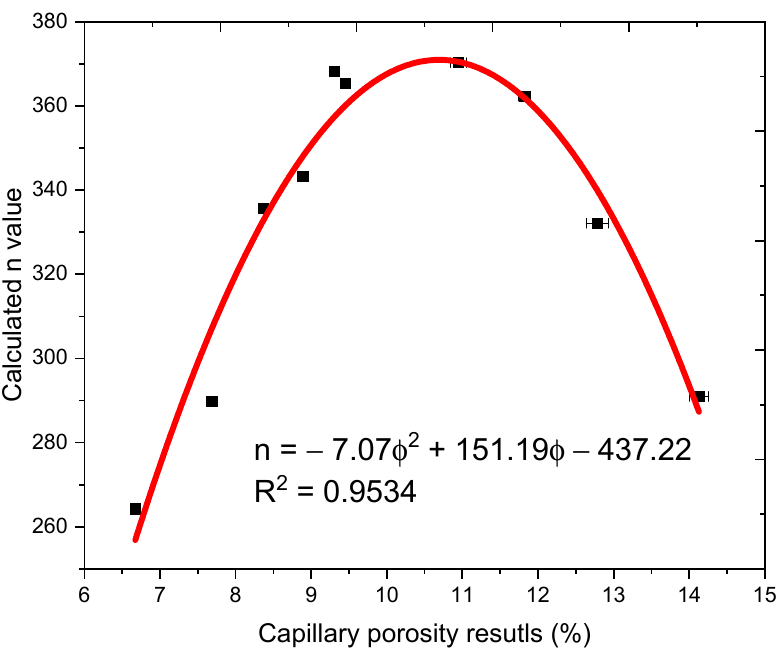
Figure 10. Calculated n value in terms of capillary porosity.